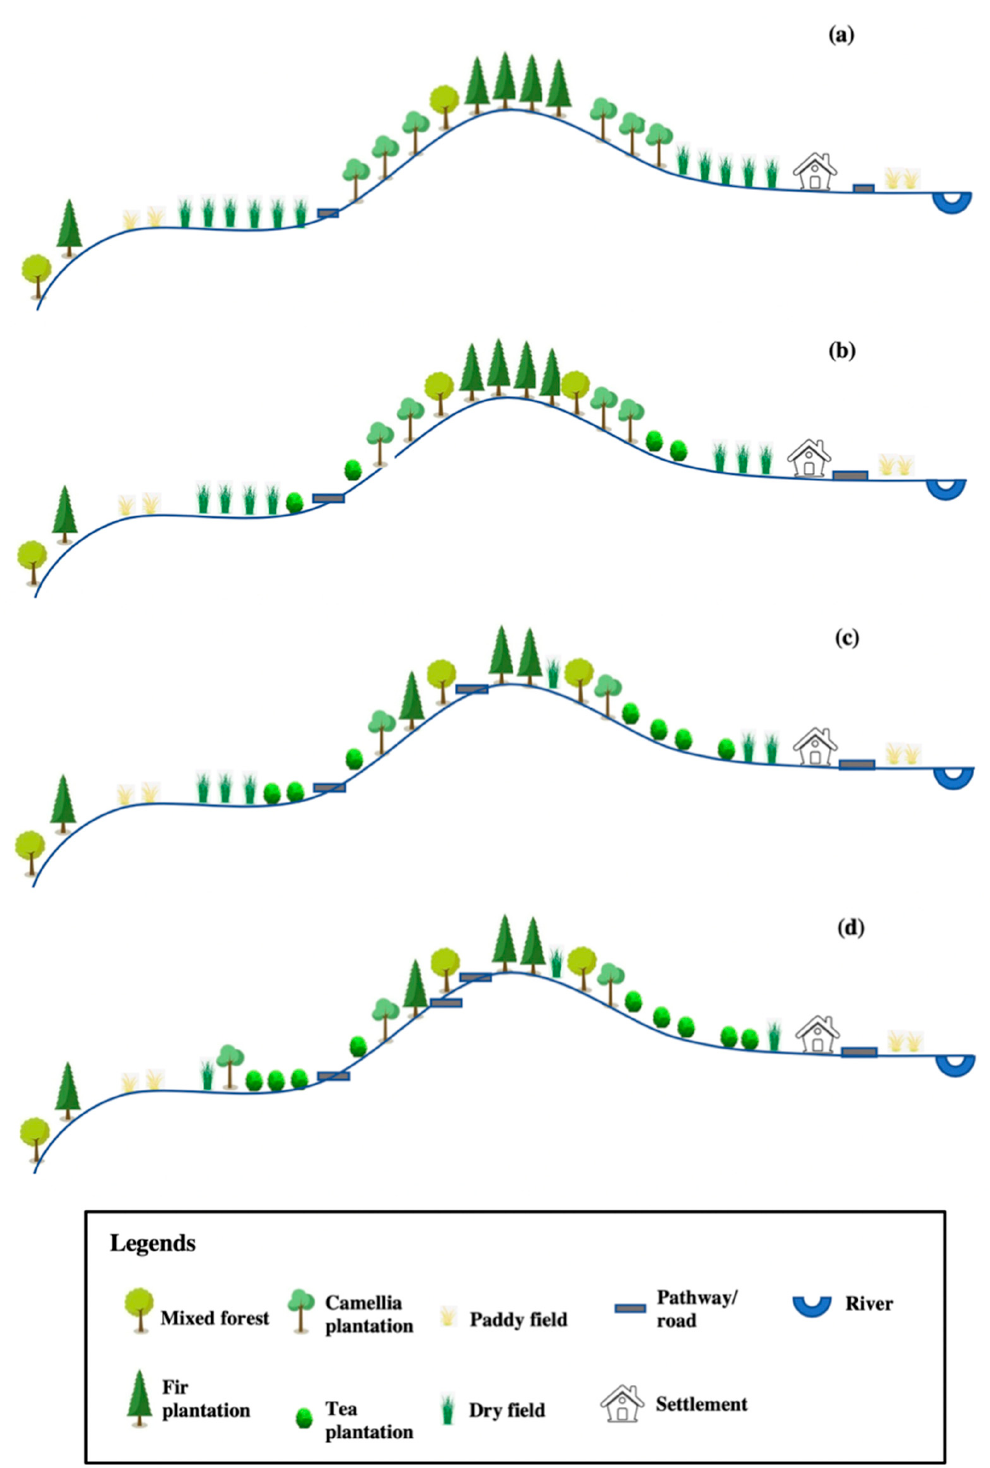
Figure 11. Transect models of land-use change: ( a ) around 1990; ( b ) 2009; ( c ) 2019; ( d ) 2020.